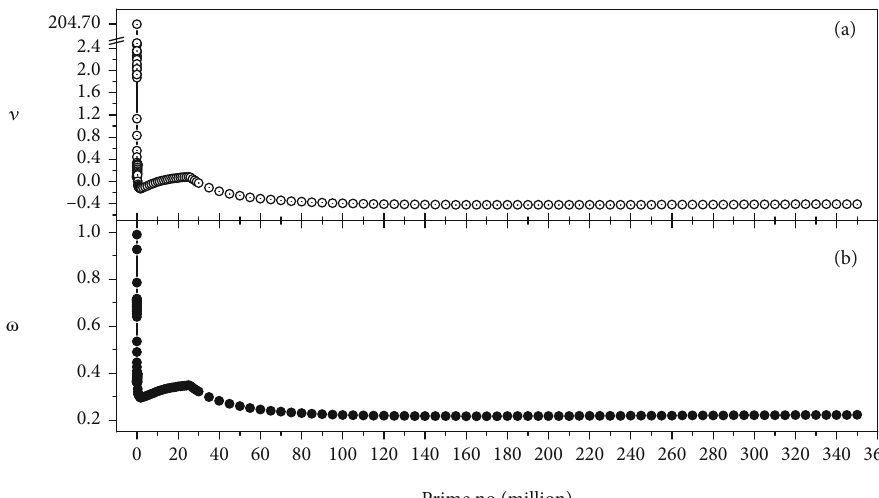
Figure 6: (a) The relation between the accumulated prime numbers and the inverse χ 2 parameter ν from 100 to 350 million primes. (b) The relation between the accumulated prime numbers and the Brody parameter ω from 100 to 350 million primes.